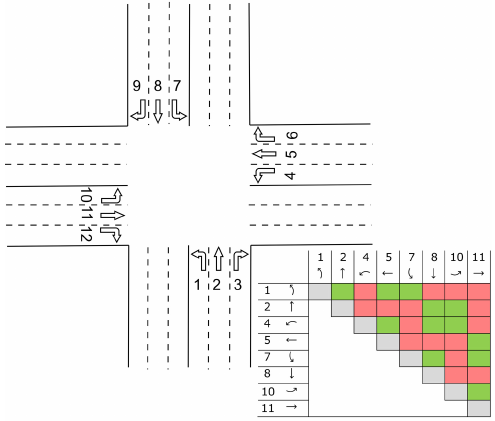
Figure 4. Intersection layout for case study I; non-conflict (green) and conflict (red) sets of